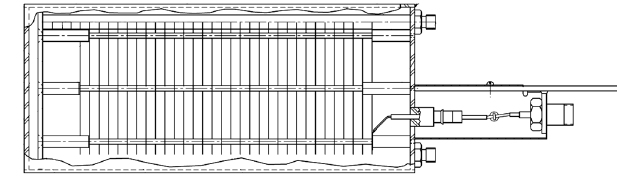
FIG. 2. Cutaway view of a PIC. The housing is a stainless-steel cylinder with a 114-mm outer diameter and a 270-mm length. The 32 plates each have an area of 56 . 5 cm 2 and are d ¼ 6 . 15 mm apart. The plates are alternately grounded or connected to a bias voltage.